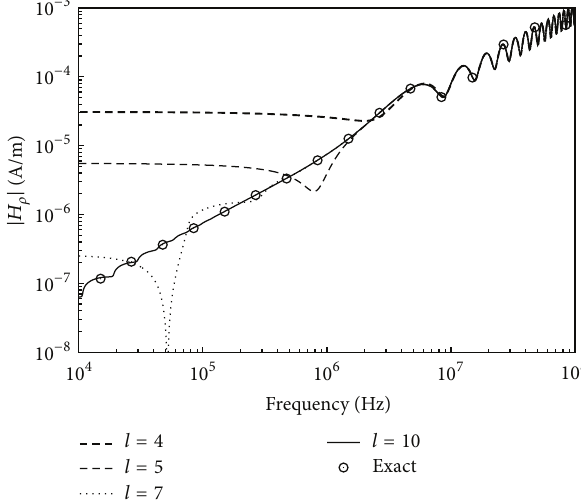
Figure 4: Amplitude-frequency spectrum of 𝐻 𝜌 , computed at 𝜌 = 20 m from the source